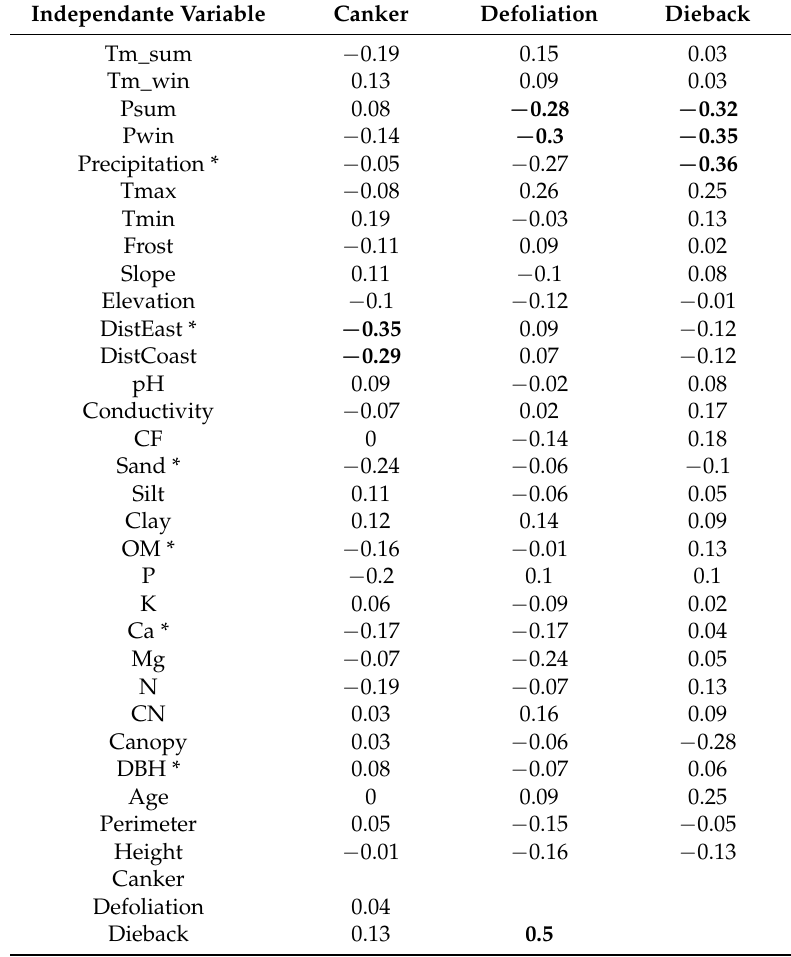
Table 2. Spearman correlation coefficient between the independent variables and the three symptomatic variables. Significant correlations are in bold letters ( p value < 0.05). Variables marked with * were removed from further analysis due to